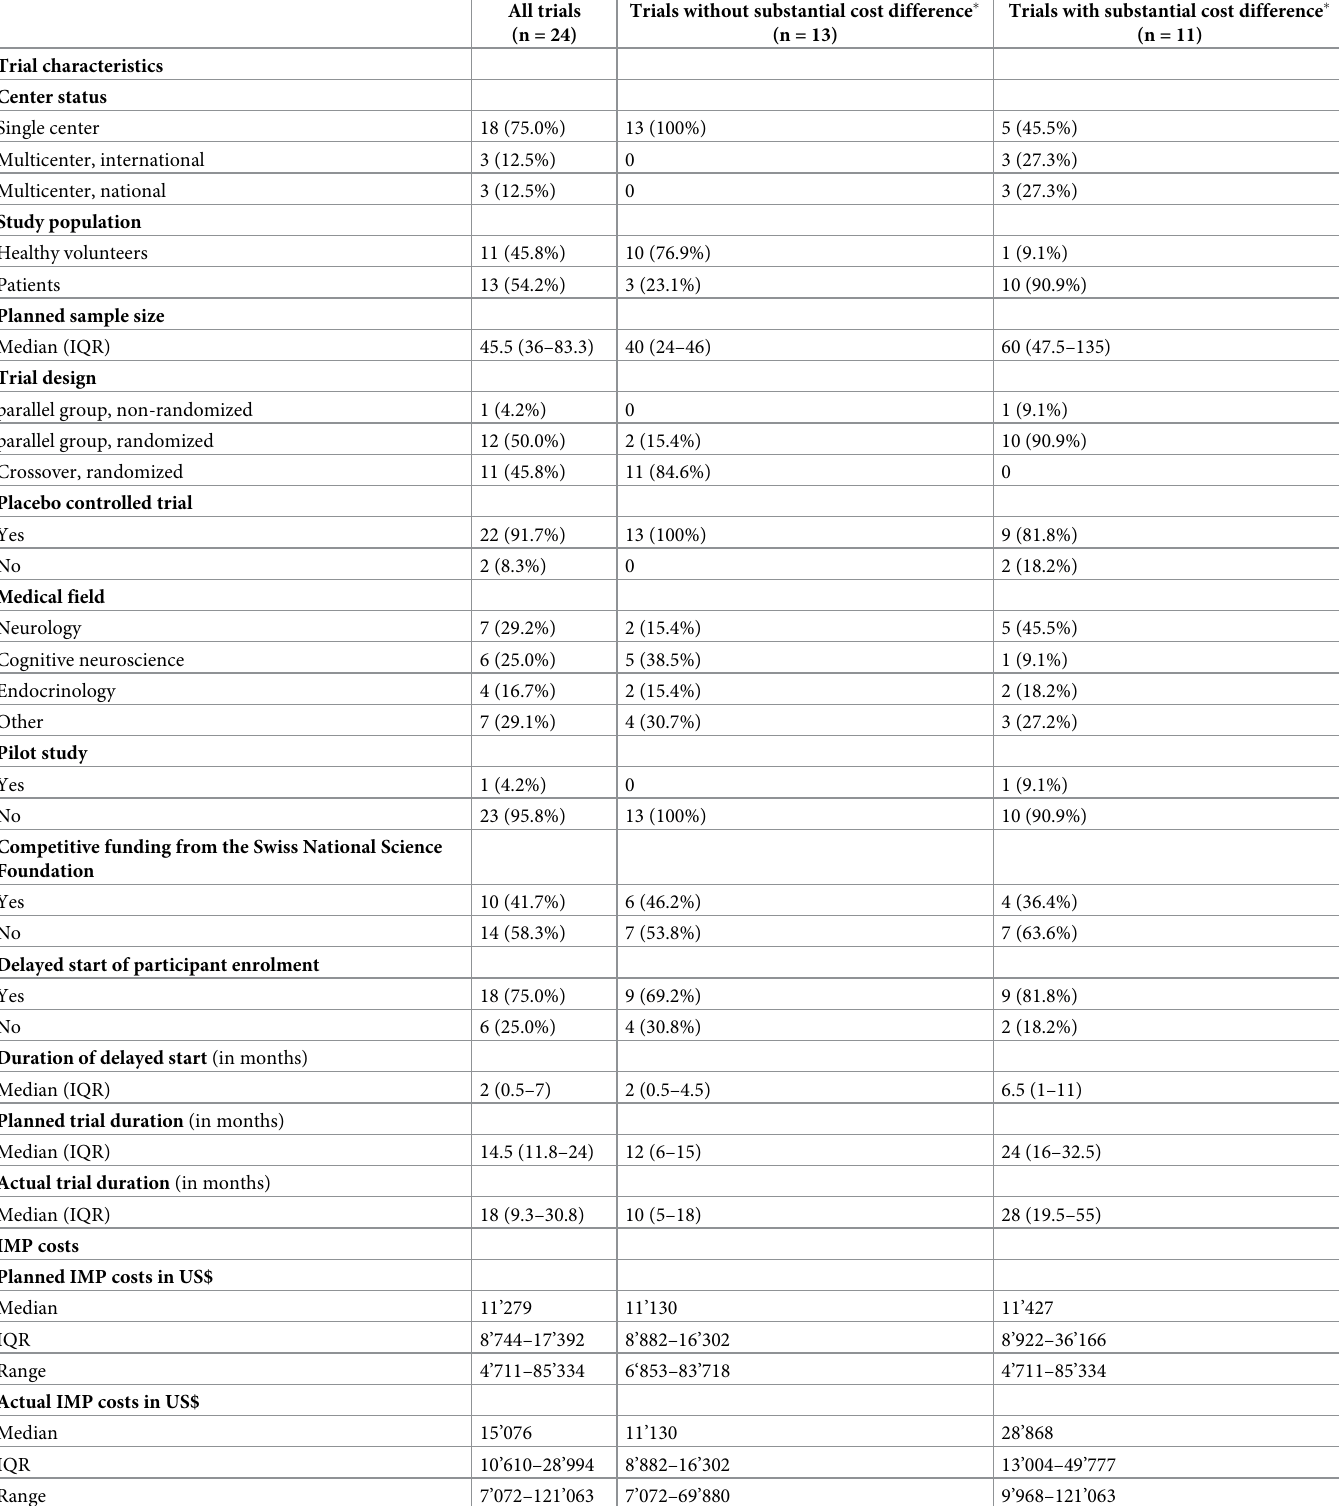
Table 1. Characteristics of included investigator-initiated trials with and without substantial IMP cost difference � .